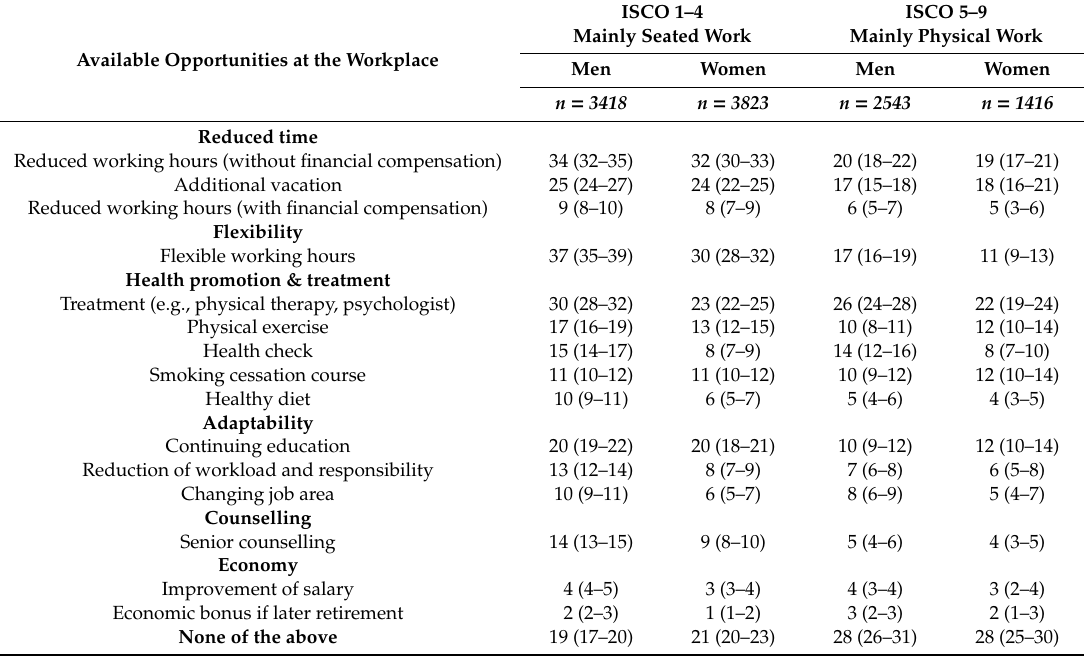
Table 2. Availability of di ff erent opportunities at the workplace among men and women in ISCO groups 1–4 and 5–9, respectively, provided as prevalence (percentage of respondents) and 95% confidence intervals. ORs for ISCO group 5–9 (ref: ISCO groups 1–4) and women (ref: men) are provided in the last two